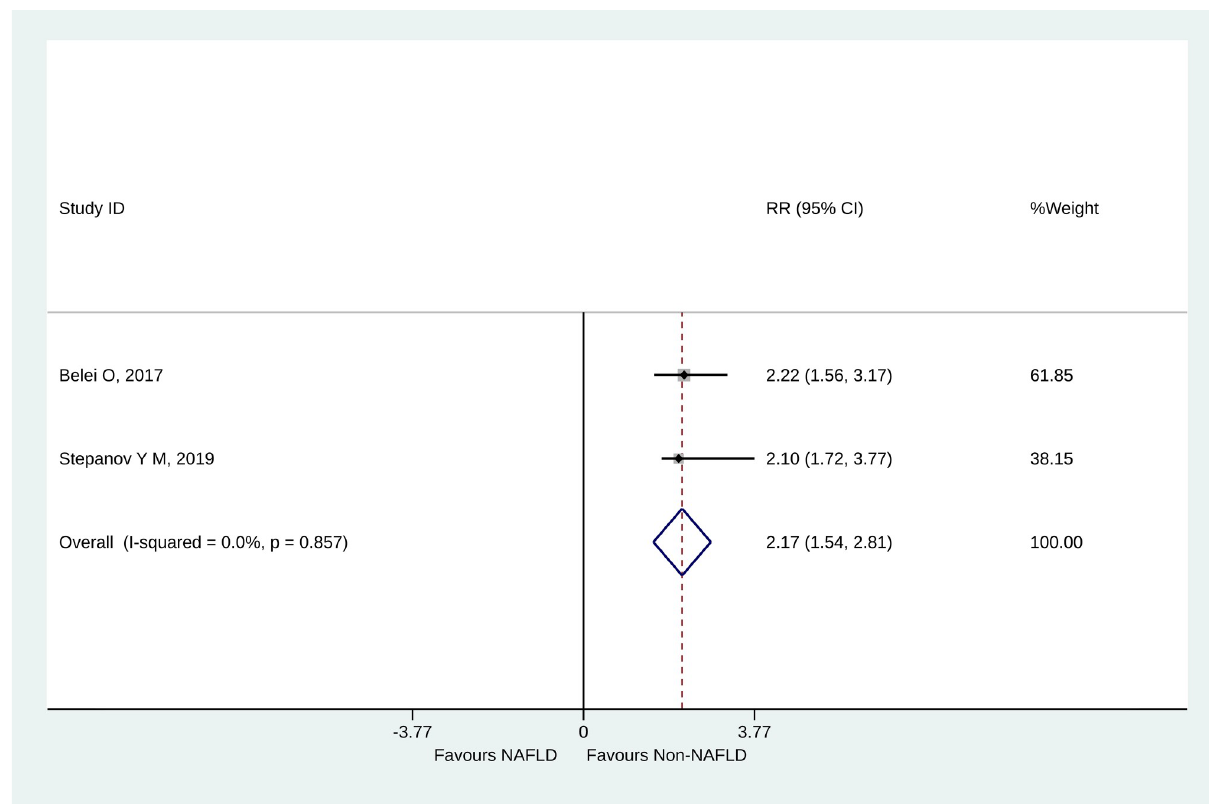
Fig 3. Forest plot of NAFLD (pooled from RR and 95%CI